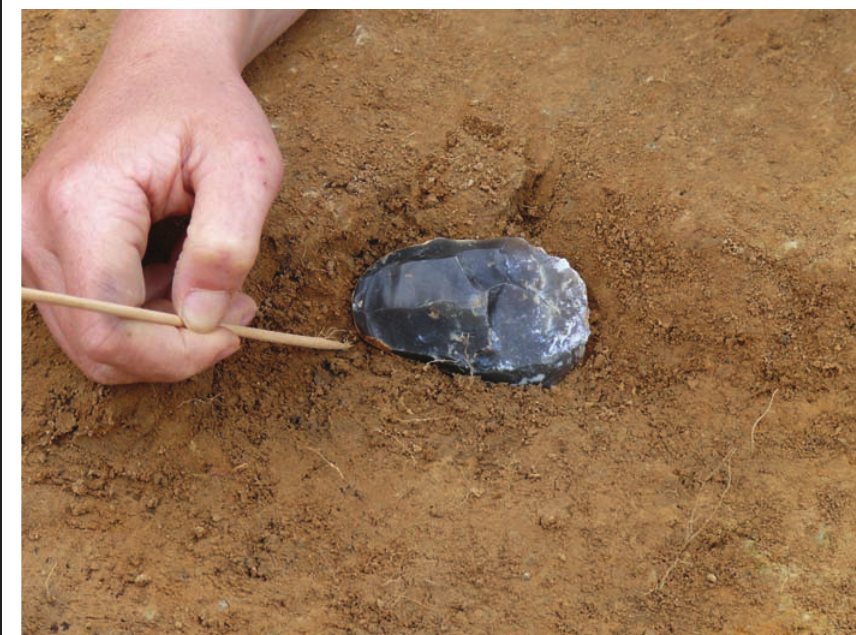
Figure 5 Upper Palaeolithic blade core under excavation